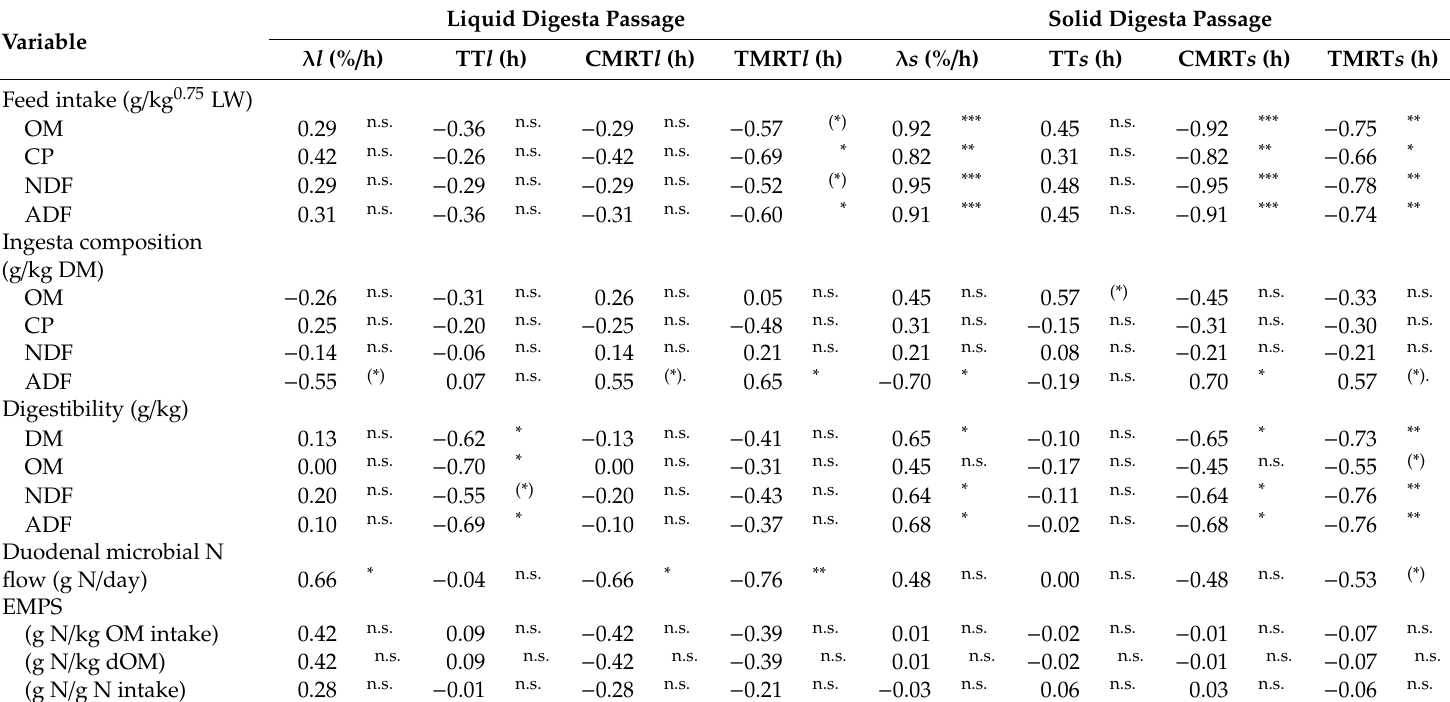
Table 4. Spearman correlation coe ffi cients (r s ) and significance levels 1 of the individual relationships between quantitative intake, ingesta concentration and digestibility of organic matter (OM), crude protein (CP), neutral detergent fiber (NDF), acid detergent fiber (ADF), duodenal microbial nitrogen (N) flow, and e ffi ciency of rumen microbial protein synthesis (EMPS) with liquid ( l ) and solid ( s ) ruminal passage rate ( λ ), post ruminal transit time (TT), rumen retention time (CMRT)